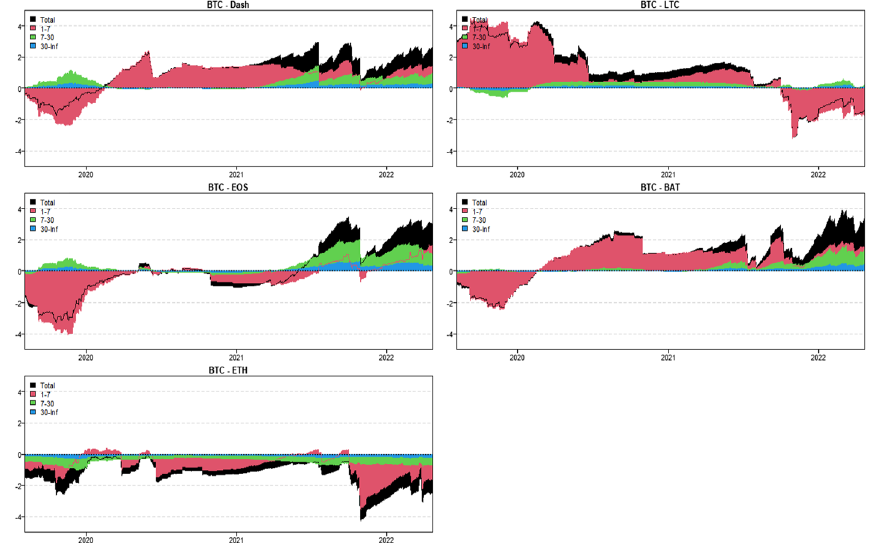
Fig. 17 Dynamic net-pairwise connectedness—realized kurtosis